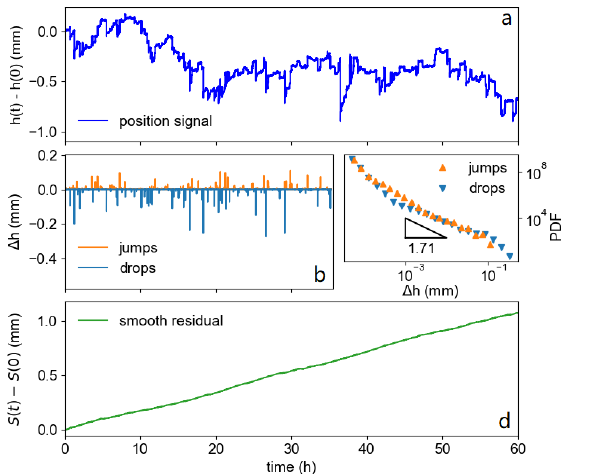
Figure 2. (a) The position signal h ( t ) can be split into (d) a smooth dilation S ( t ) and (b) sudden discontinuities (jumps or drops), denoted as ∆ h . (c) Discontinuities distribute following a power-law-like distribution over three orders of magnitude. The time x-axis is shared for all plots except (c) .